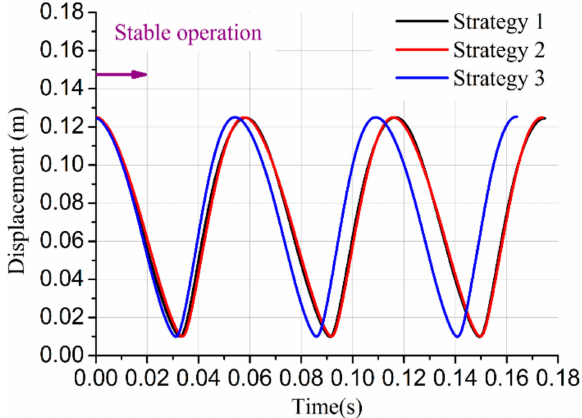
Figure 17. Piston displeacement diagram.